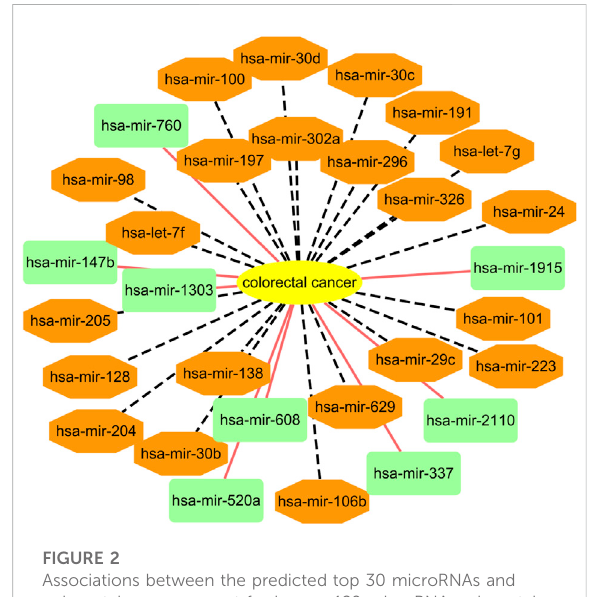
FIGURE 1 Associations between the predicted top 30 microRNAs and colon cancer except for known 73 microRNA-colon cancer associations in the HMDD database that are predicted to have the highest association scores with colon cancer. Black dot lines denote associations between microRNAs and colon cancer and these associations have been reported by publications. Blue dot lines denote associations between microRNAs and colon cancer and these associations are unknown and need to experimental validation.